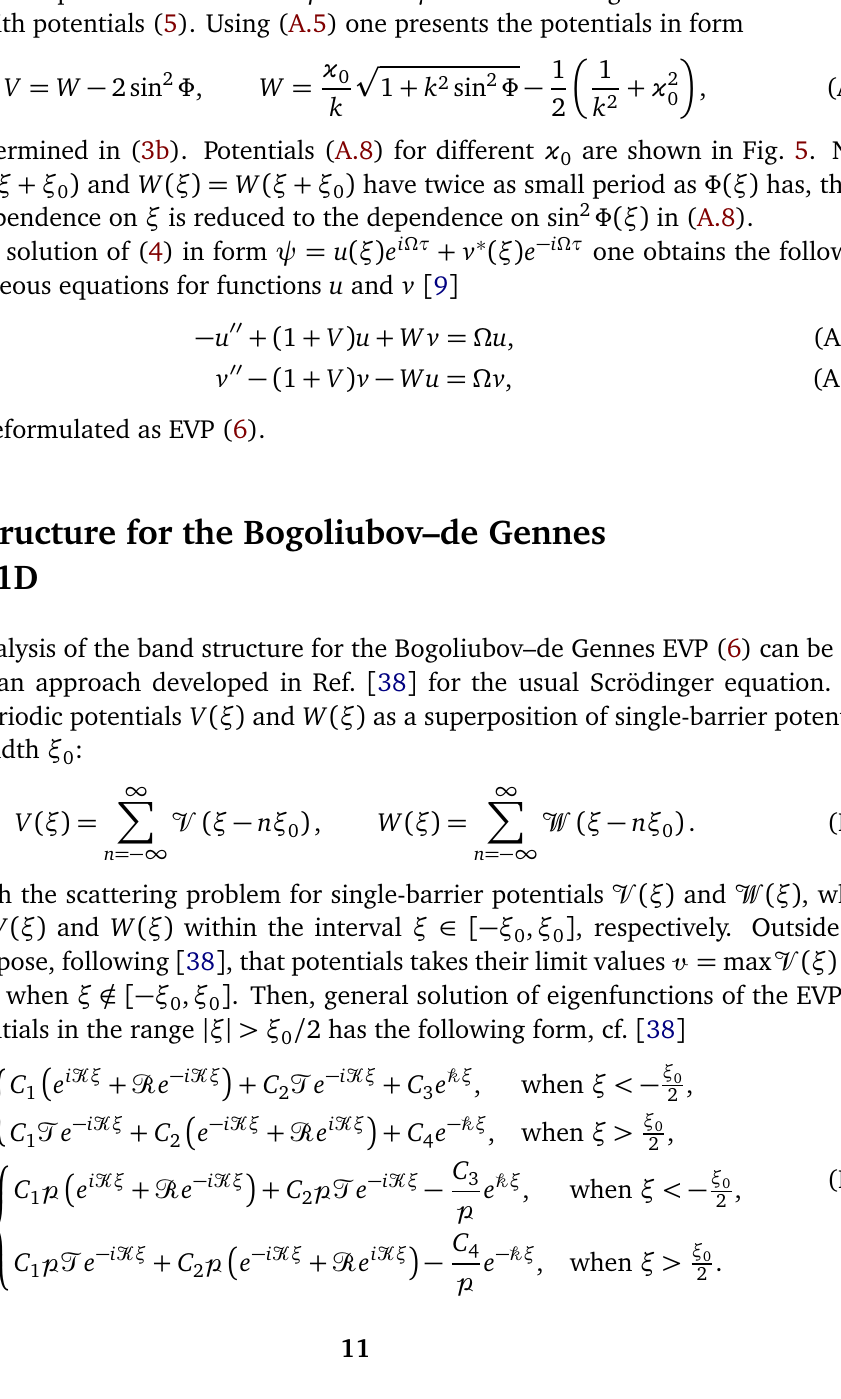
= 0.1 and (cid:99) 0